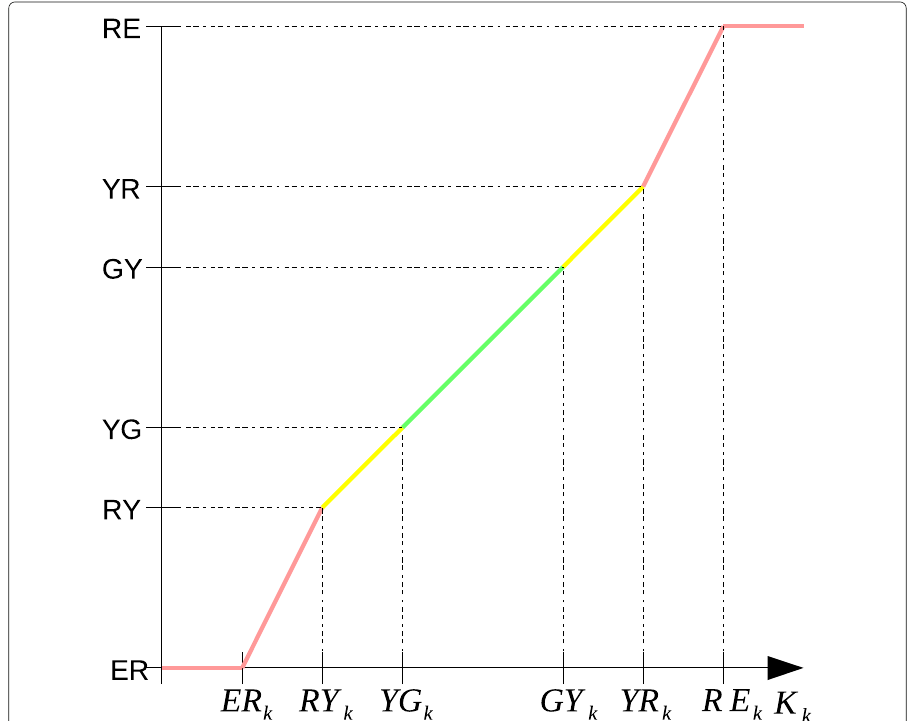
Fig. 3 The translation function t k ( x ) that translates KPI values to PQ-Indic